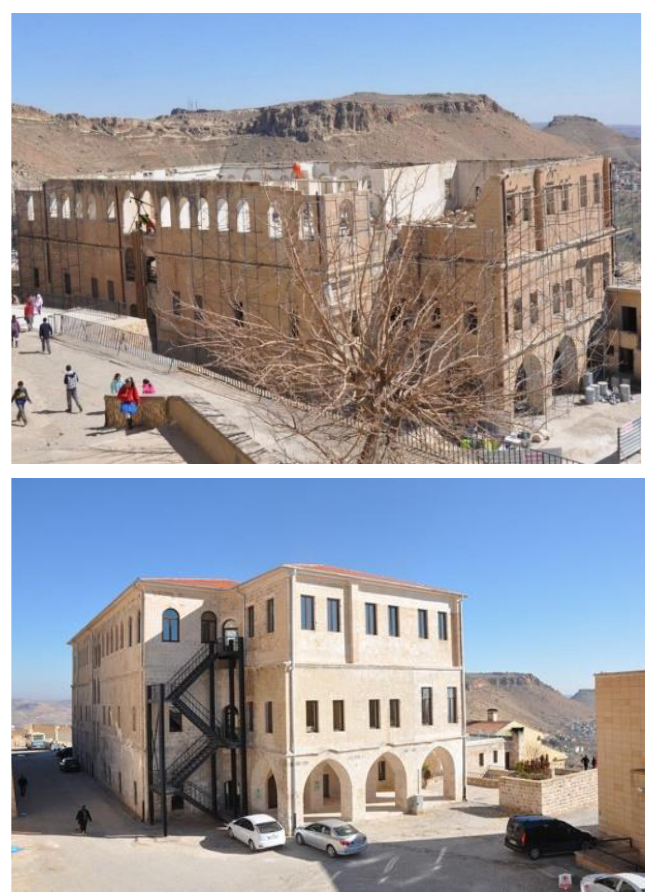
Fig. 13. Faculty building – a) Reconstruction of the second floor and roof during the period the building was restored in 2009 [40], b) Today's